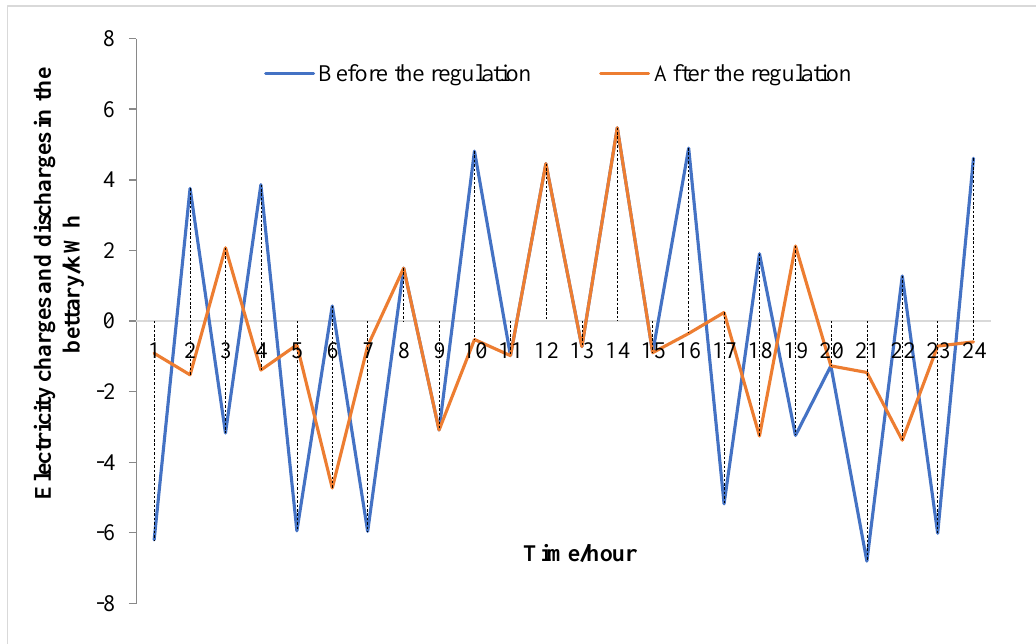
Figure 8. The charge and discharge of the battery before and after the dispatch.